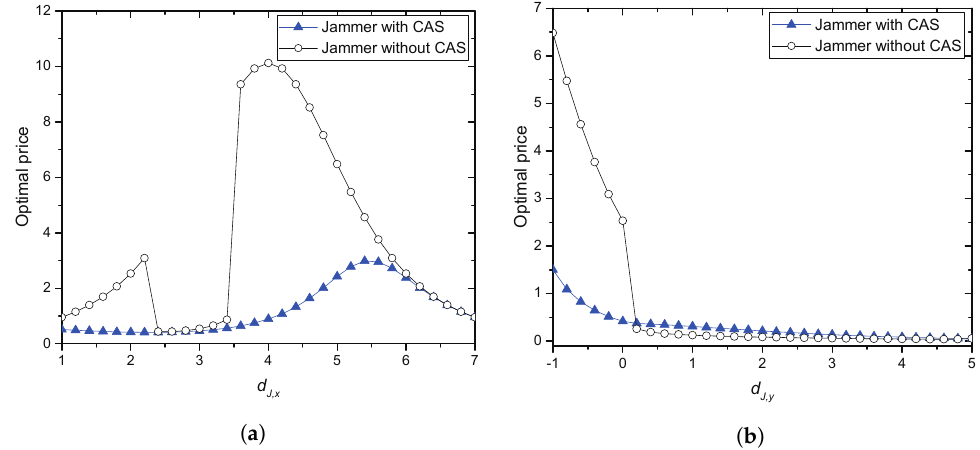
Figure 3. Optimal prices. ( a ) the jammer moves horizontally; ( b ) the jammer moves vertically.